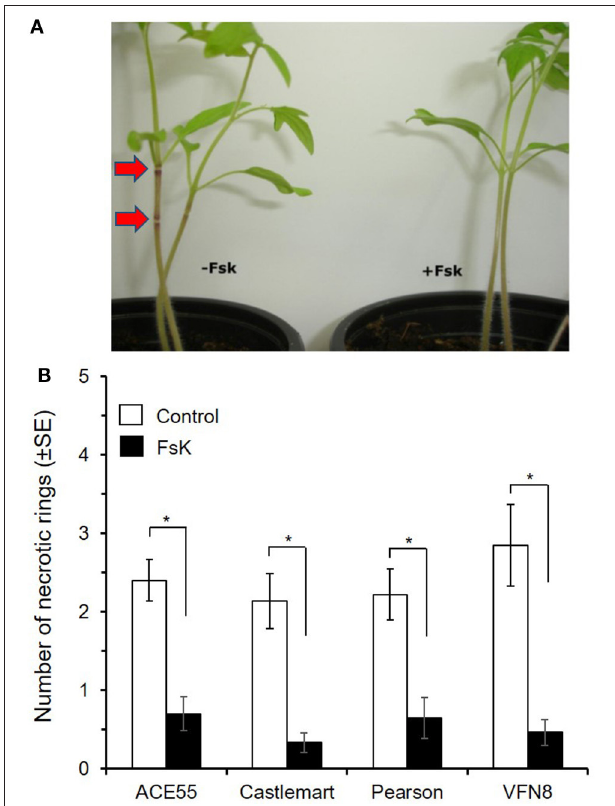
FIGURE 1 | Plant damage by Nesidiocoris tenuis is reduced on tomato plants inoculated with Fusarium solani strain K (FsK). Tomato FsK-inoculated (black bars, N = 10–17) or control (white bars, N = 10–18) plants were exposed to N. tenuis (one male, one female) for 1 week. (A) Necrotic rings (red arrows, left) caused by N. tenuis feeding on ACE55 control (-FsK) plants compared to FsK-inoculated ( + FsK, right) plants where no symptoms are depicted (B) Mean ( ± SE) total number of necrotic rings on stems and leaves recorded for each tomato cultivar (ACE55, Castlemart, Pearson, VFN8) on day 7. Asterisks indicate significant differences within each cultivar after Student t -test ( P <